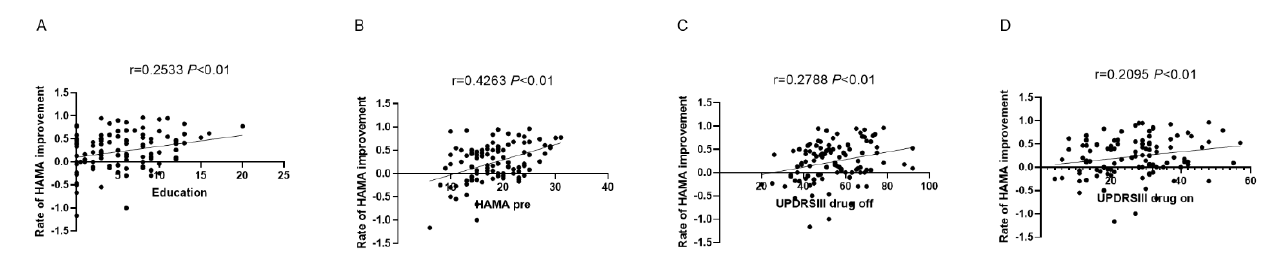
Figure 2. Correlations of HAMA score improvement rate with education ( A ), HAMA preop ( B ), UPDRSIII drug off ( C ) and on ( D ).